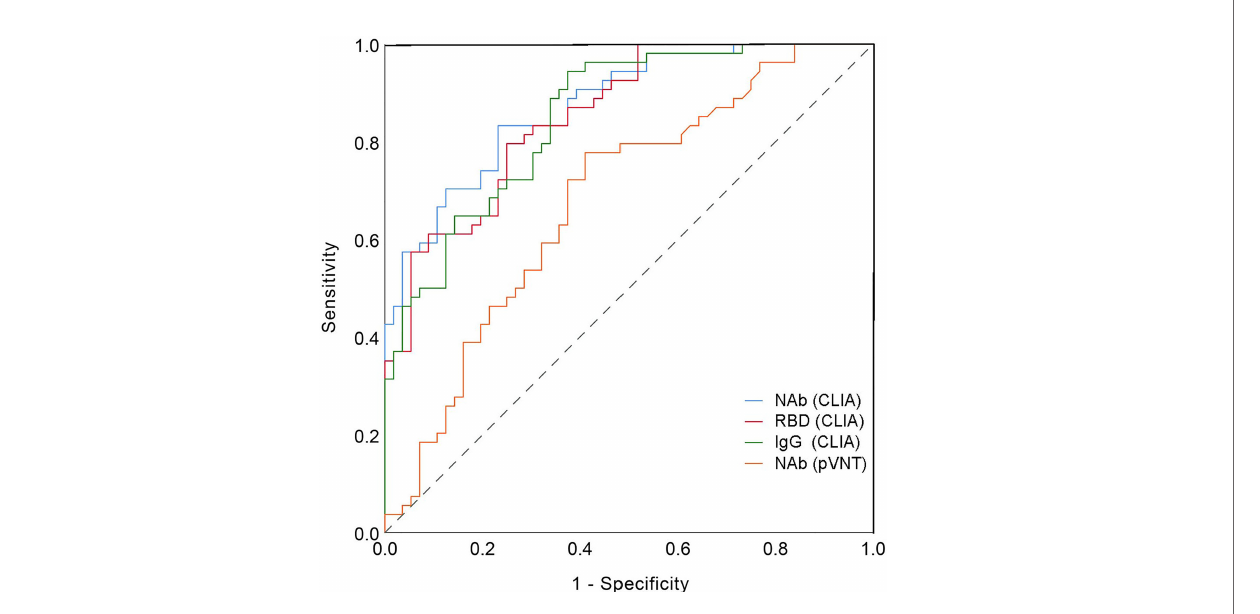
FIGURE 6 | Receiver operating curve